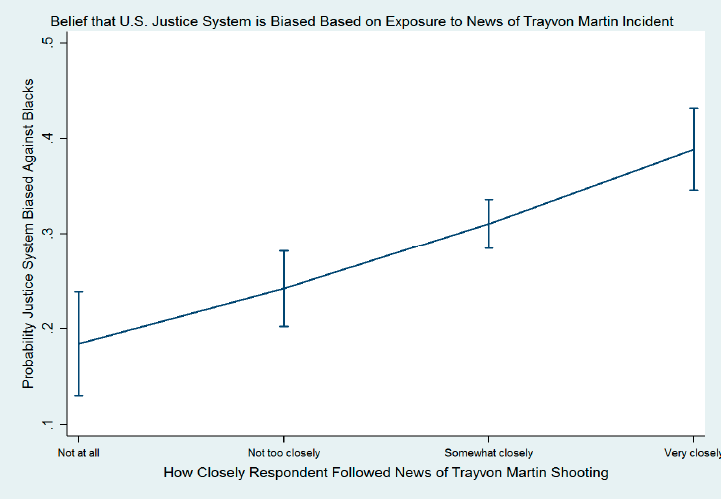
Figure 6. Respondents Perceptions of Bias Based on Media Exposure.